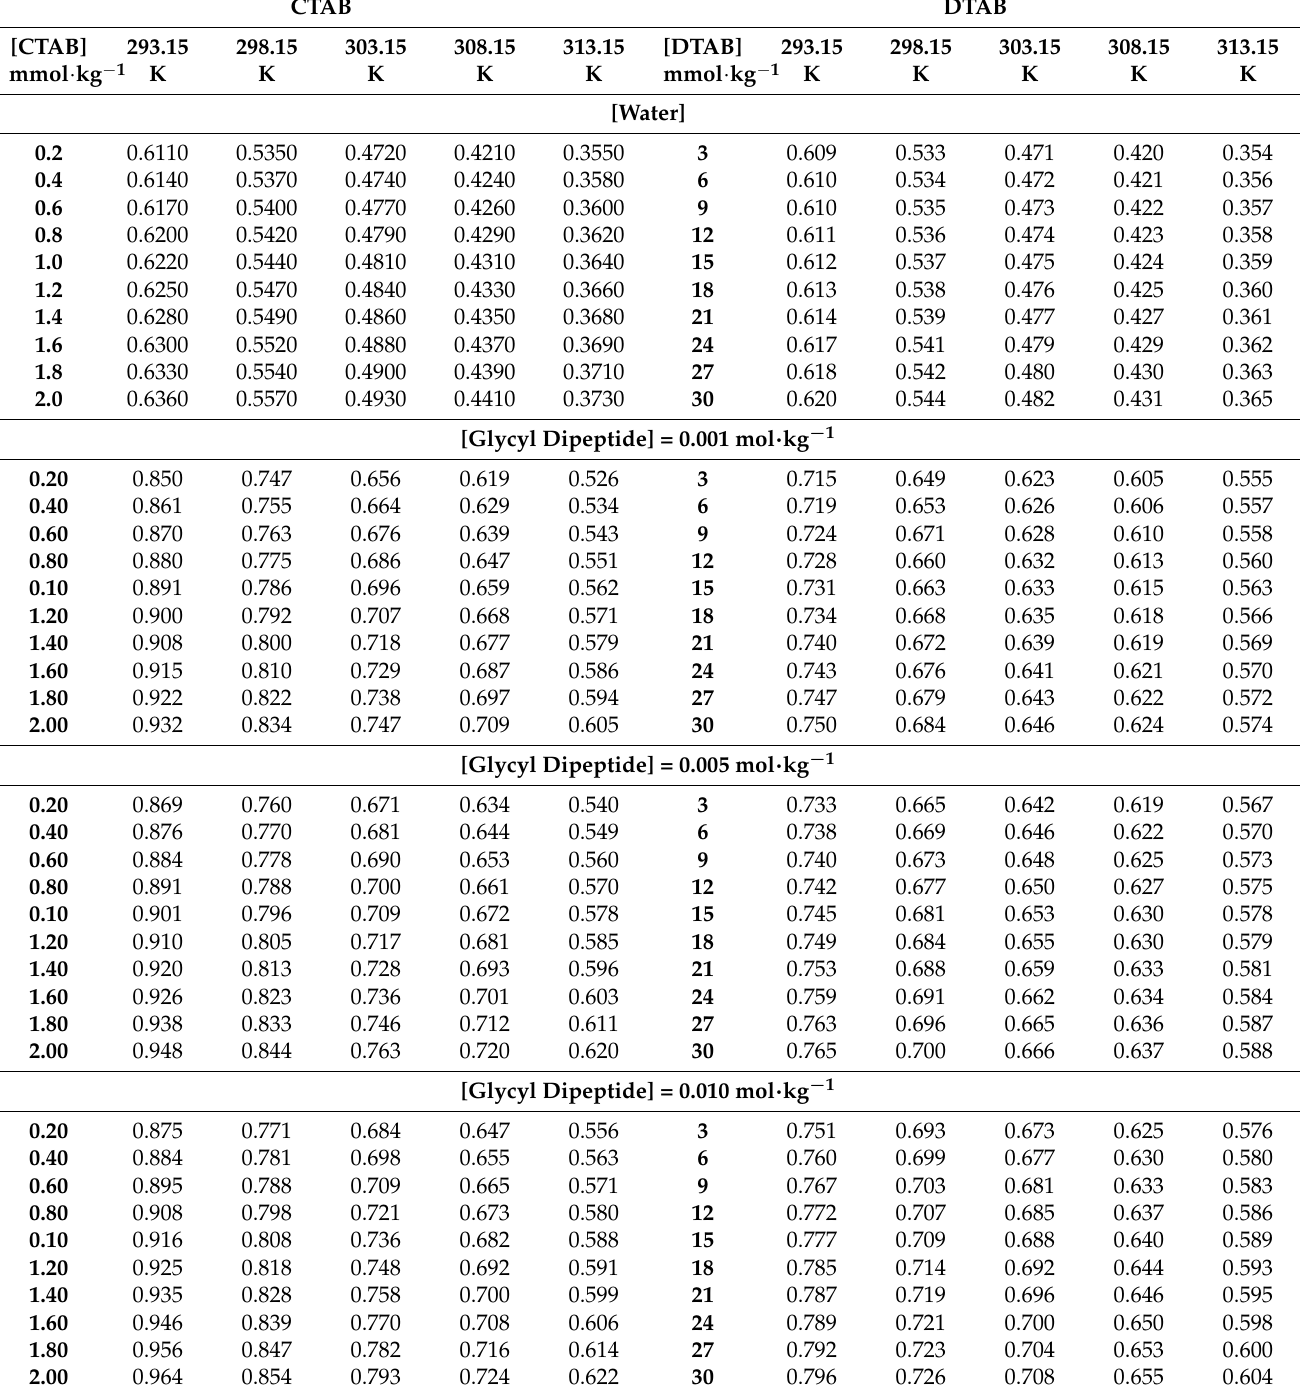
Table 6. Viscous relaxation time, τ (ps) values for CTAB and DTAB in pure water and 0.001,